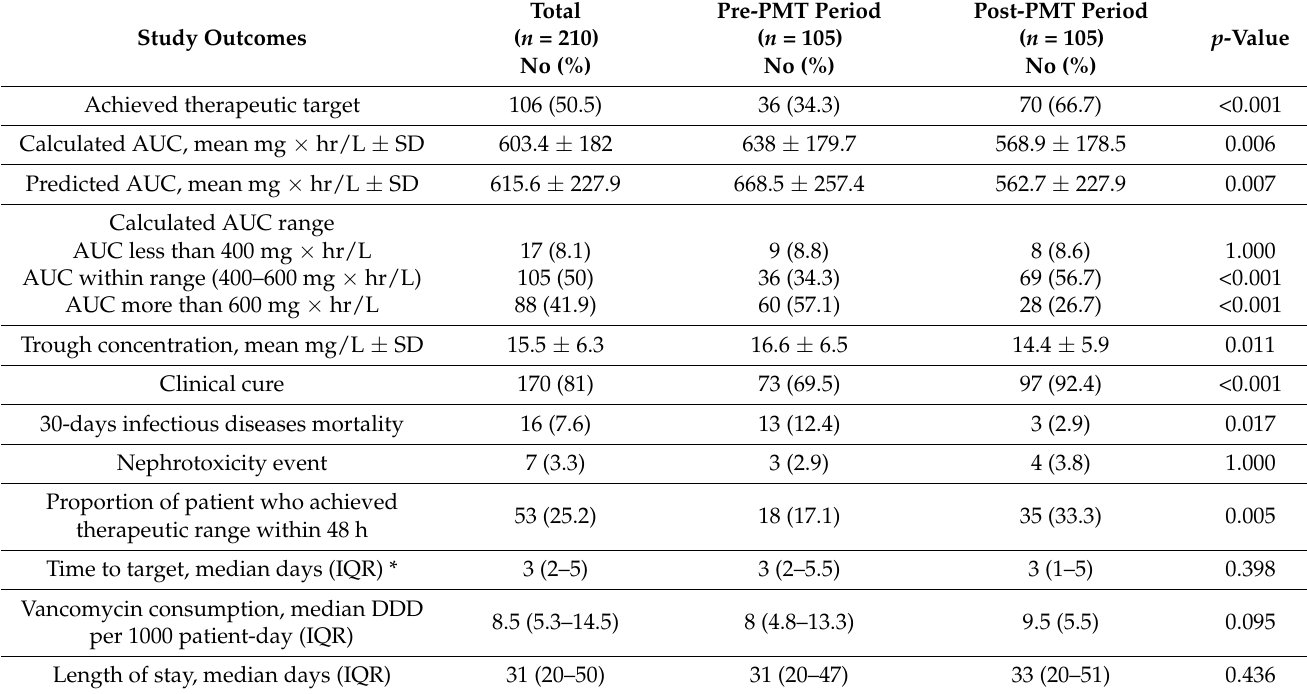
Table 2. Study outcomes.